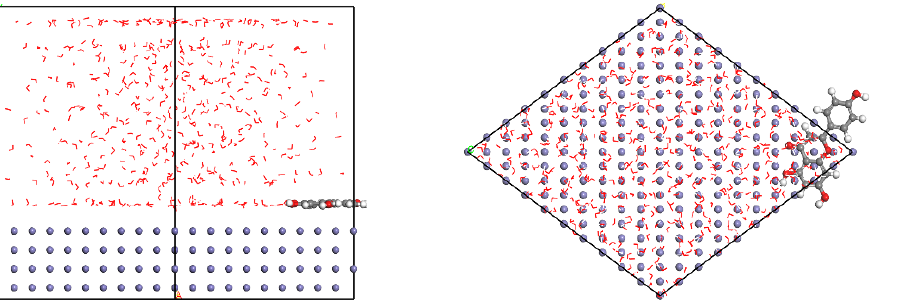
Figure 14. The adsorption configuration of apigenin molecule on Fe (110) surface.